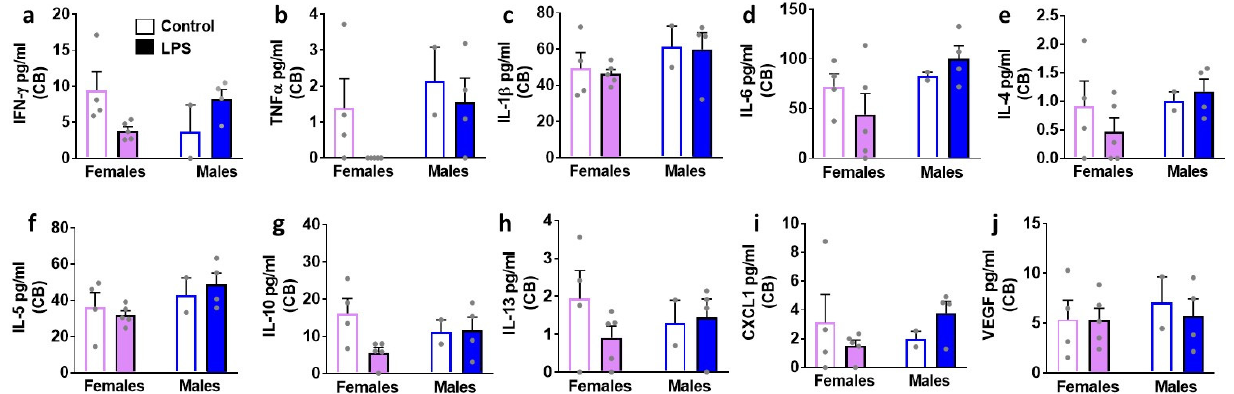
Figure 7. Cytokines, chemokines, and VEGF were measured in the cerebellum (CB) of female and male rats that were exposed to saline or LPS challenges. Pro-inflammatory cytokines are indicated in panels ( a – d ). Anti-inflammatory cytokines are indicated in panels ( e – h ). Chemokine is indicated in panel ( i ) and angiogenesis marker is indicated in panel ( j ). Data are represented as mean ± S.E.M. n = 4 control female, n = 5 LPS female, n = 2 control male, n = 4 LPS male. No significant differences were seen in any of the markers studied.